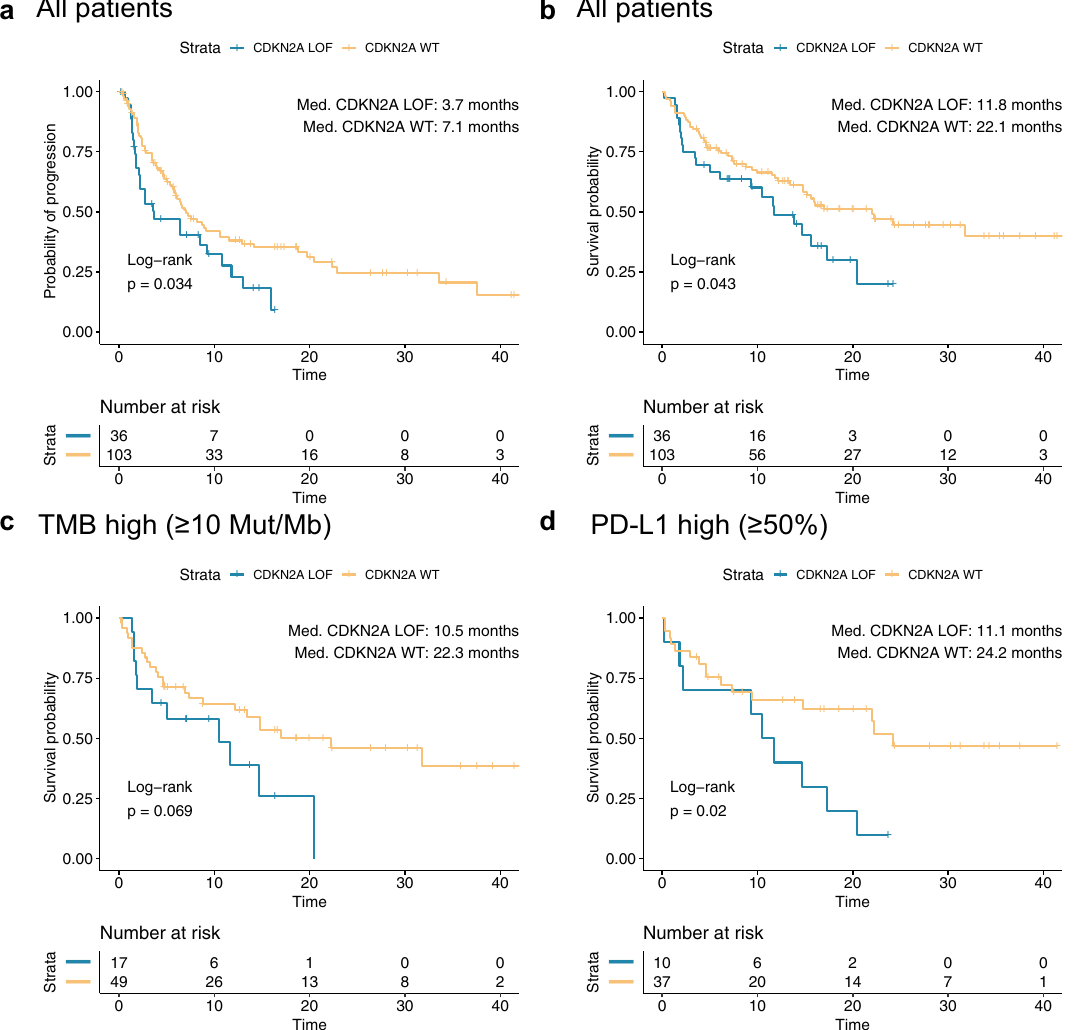
Figure 3. CDKN2A LOF and survival. Kaplan–Meier curves of patients with CDKN2A wild-type (WT) and loss-of-function (LOF) NSCLC demonstrating ( a ) PFS for entire cohort, ( b ) OS for entire cohort, ( c ) OS for high TMB subset (≥ 10 mutations/megabase), and ( d ) OS for high PD-L1 subset (≥